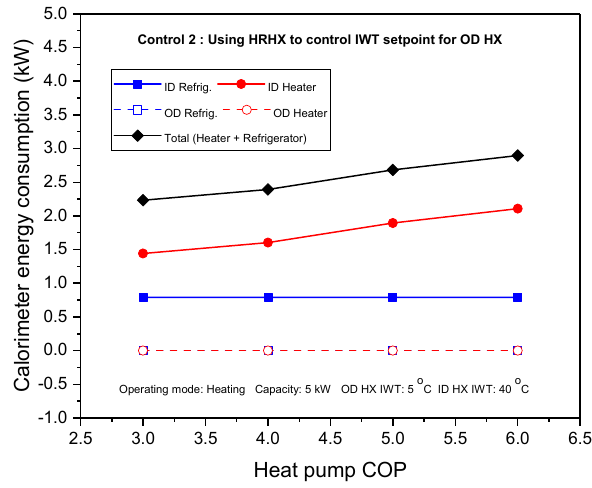
Figure 9. Calorimeter energy consumption with heating COP variation in control (2).